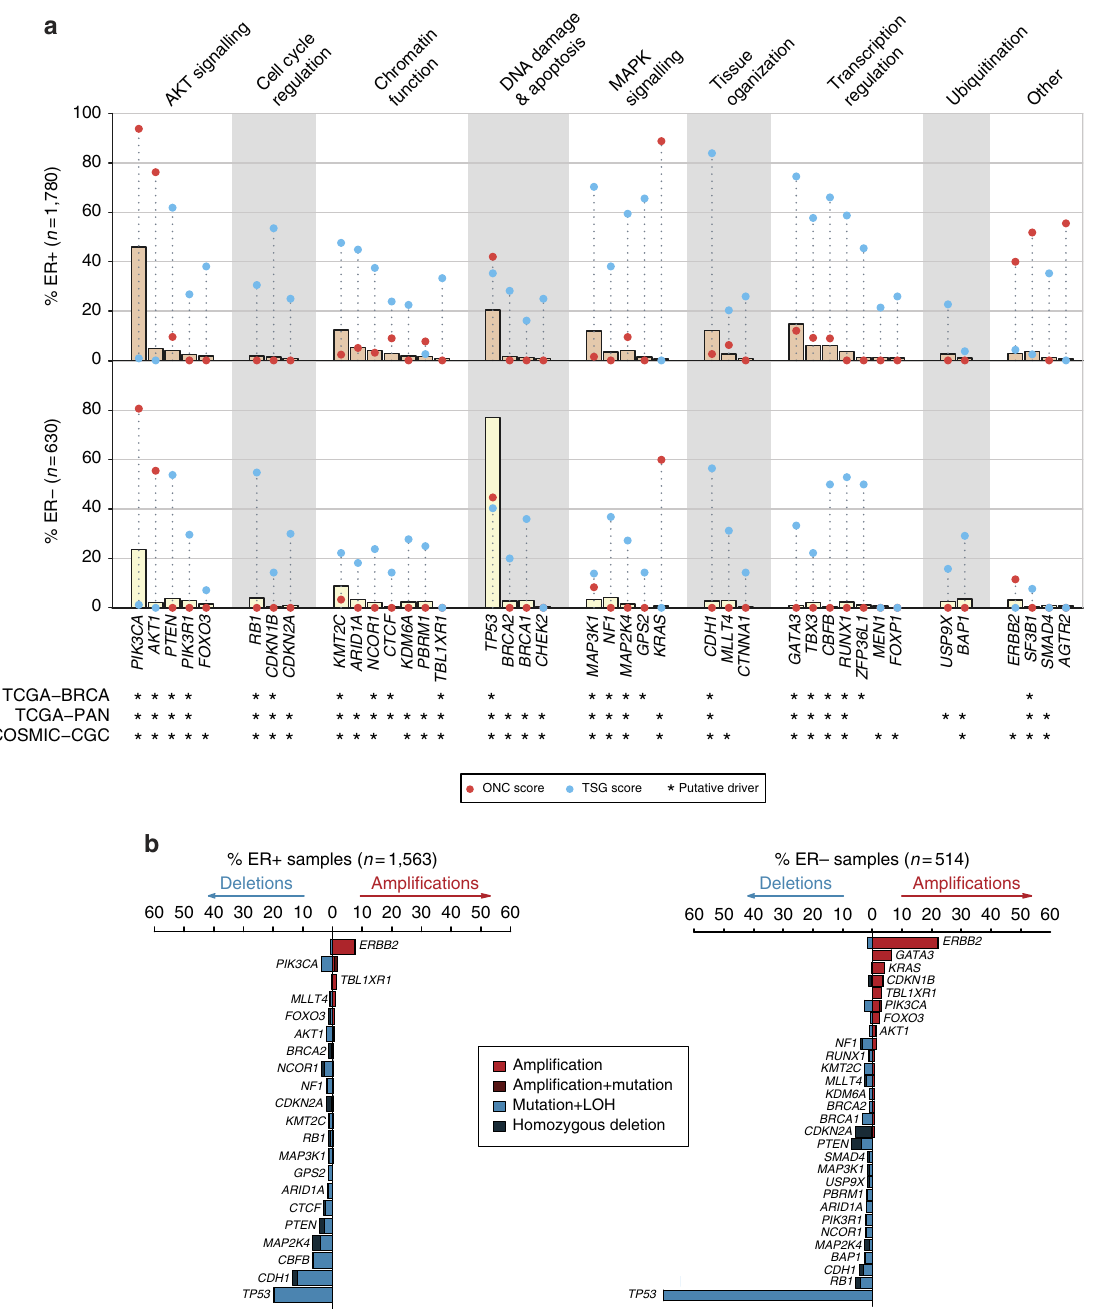
Figure 1 | Identification of 40 mutation-driver genes in 2,433 primary breast cancer samples. ( a ) Bars depict proportions of ER þ and ER (cid:3) samples harbouring mutations in mutation-driver (Mut-driver) genes. Red and blue points indicate for each gene, the proportions of recurrent (oncogene; ONC score) and inactivating (tumour suppressor gene; TSG score) mutations, respectively. ‘ (cid:4) ’ indicates genes previously highlighted in other studies: COSMIC, Cancer gene census from the Catalogue of Somatic Mutations in Cancer; TCGA-BRCA, TCGA breast cancer study; TCGA-PAN, TCGA pan-cancer analysis. ER status available for 2,410 tumours. MAPK, mitogen-activated protein kinase. The genes are grouped by pathway or function. ( b ) Bars depict proportion of tumours with copy number alterations (CNAs) in genes altered in at least 1% of ER þ or ER (cid:3) samples. The percentages of tumours with amplifications, simultaneous amplification and mutation events, homozygous deletions and simultaneous mutations and LOH events are shown. LOH was defined as any CNA in which with either the major or minor allele was entirely deleted as determined by ASCAT (Methods). RUNX1 (also known as AML1 ; ER þ : 59%, 3.7%; ER (cid:3) : 53%, 2.4%) were also common. In addition, we observed recurrent K700E mutations in SF3B1 (ER þ : ONC ¼ 52%, 3.5%) which have recently been associated with differential splicing activity in breast tumours 17 . AGTR2 harboured 6 P271L mutations (ER þ : ONC ¼ 56%, 0.51%), and was also found to be mutated at NATURE COMMUNICATIONS|7:11479|DOI: